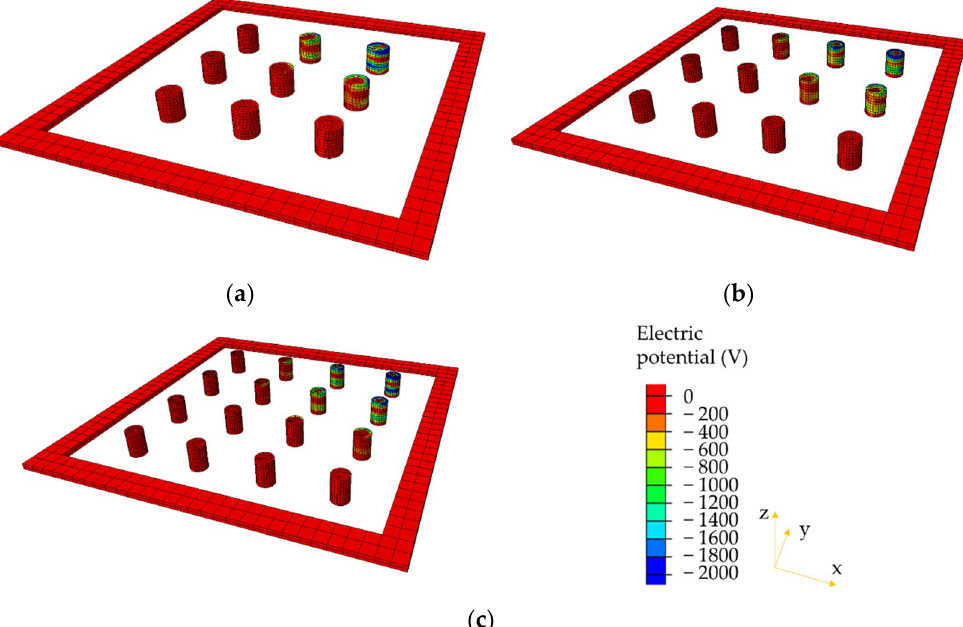
Figure 12. Electrical potential distributions in piezoelectric units under quarter loading condition: ( a ) 3 × 3 with diameter = 2 cm; ( b ) 3 × 4 with diameter = 1.73 cm; ( c ) 4 × 4 with diameter = 1.5 cm.